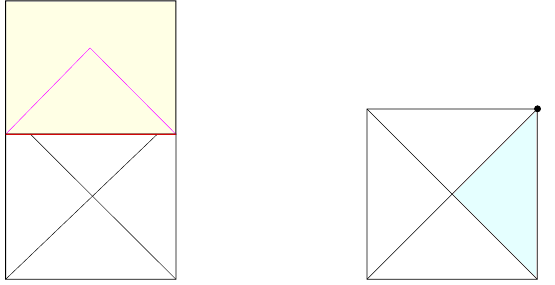
Figure 2 . Left : Penrose diagram of dS, cutoff at the reheating surface (red) and glued to the non- expanding spacetime (yellow). The lightcone of an observer that sees the entire reheating surface is indicated in purple. Right : static patch indicated in blue. It coincides with the causal past of a point (the black dot) on the late-time surface, in the expanding part of